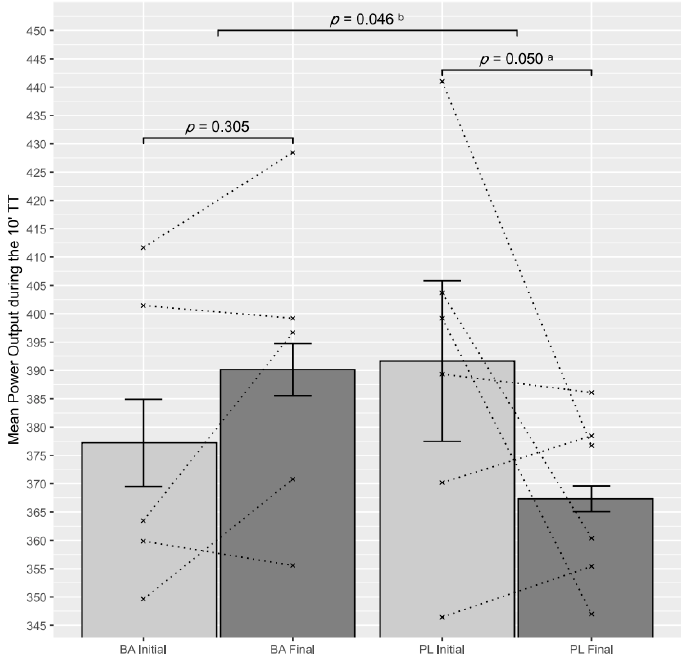
Figure 3. Mean power before and after the 10 (cid:48) TT. a : Significant Intragroup difference. b : Significant time × group difference. Table 2. Performance analysis of the 10 (cid:48) TT. Values are presented as mean with standard error of the mean between brackets. AUC: Area under the curve (calculated by trapezoidal rule). rpm: revolutions per minute. RPE: rate of perceived